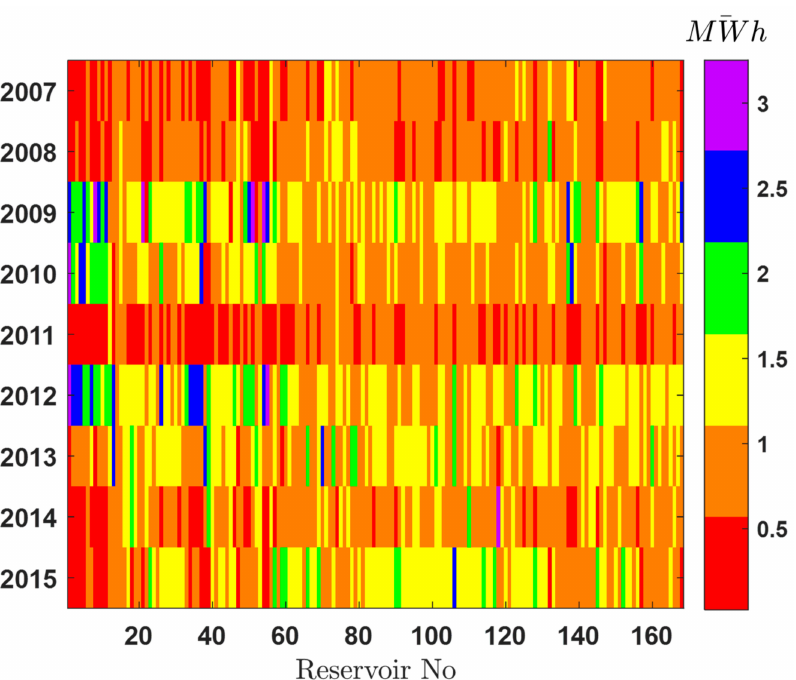
Figure 15. Normalized (by mean) total annual energy generation for studied reservoirs for 2007–2016